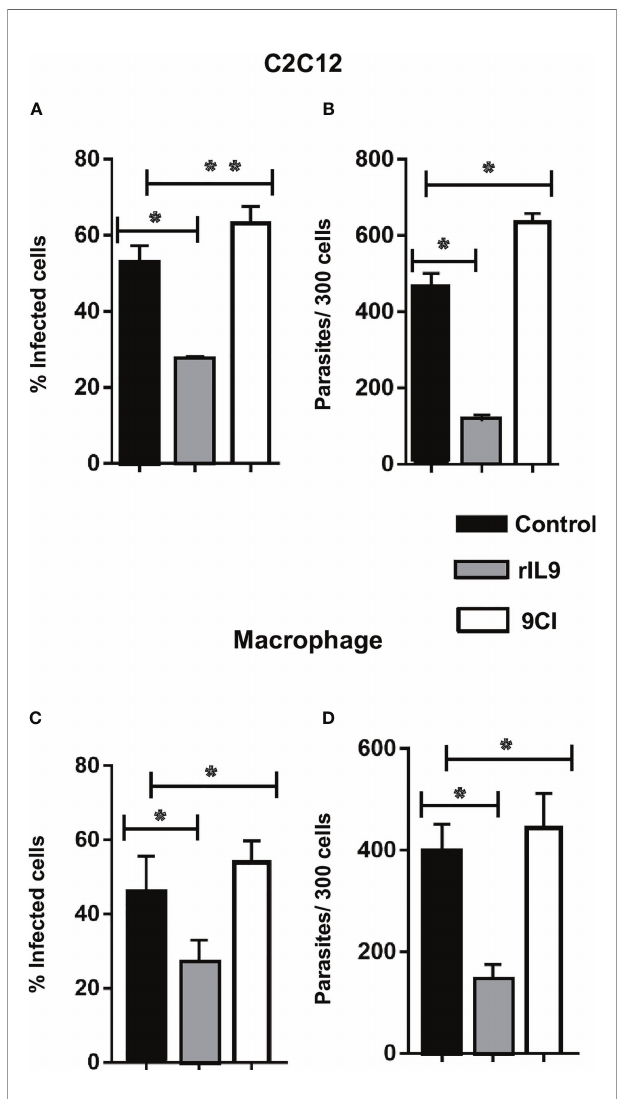
FIGURE 1 | rIL9 decreased the number of infected cells and internalized parasites in C2C12 cells and macrophages, and IL-9 neutralization (9CI) reversed the effect. C2C12 cells and macrophage were pretreated for 24 h with rIL9 (25 ng/mL or 10 ng/mL) or 9CI (1.25 µg/mL) and then infected with Trypanosoma cruzi strain Y for 3 h. The cells were fi xed with Bouin ’ s solution and then Giemsa stained. Graphs show the percentage of infected cells (A, C) and number of internalized parasites (B, D) . Student ’ s t-tests **p = 0.0172, *p < 0.001. Control: cells infected and cultured just in culture